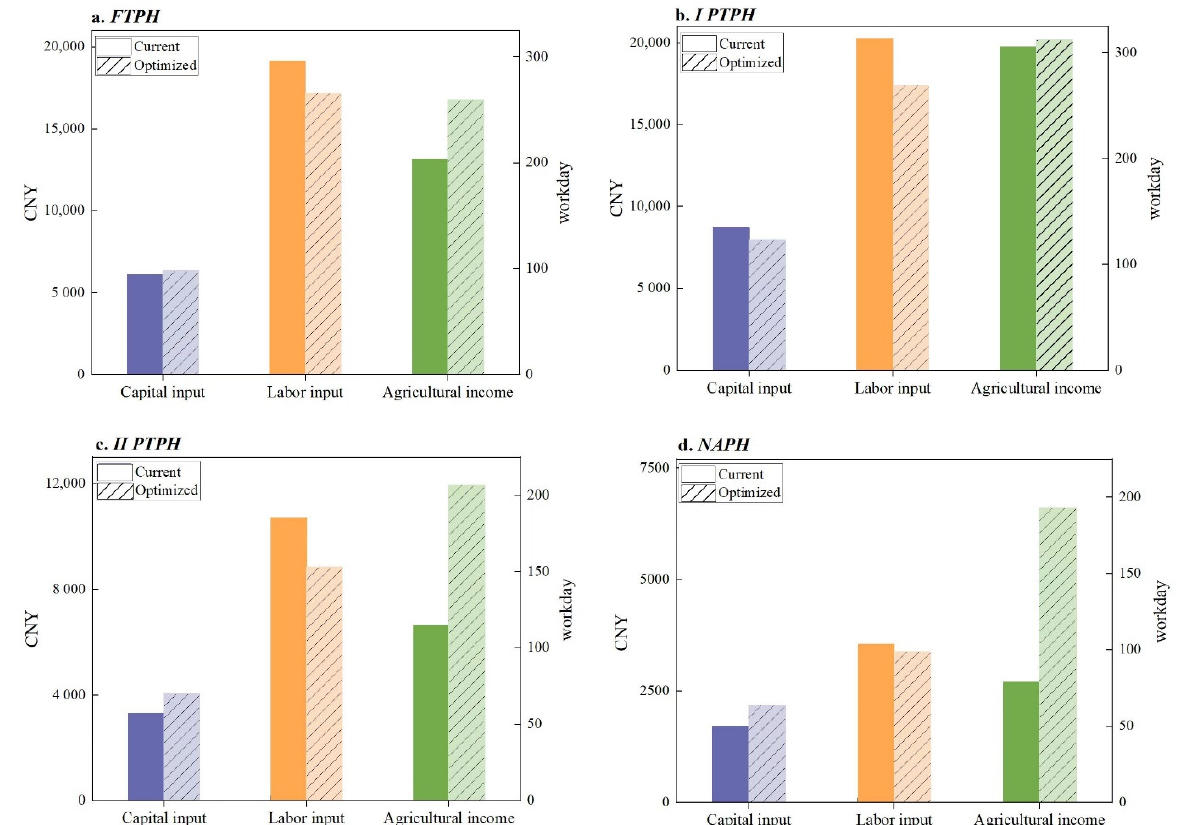
Figure 3. Comparison of agricultural inputs and incomes of different types of peasant households before and after optimization.